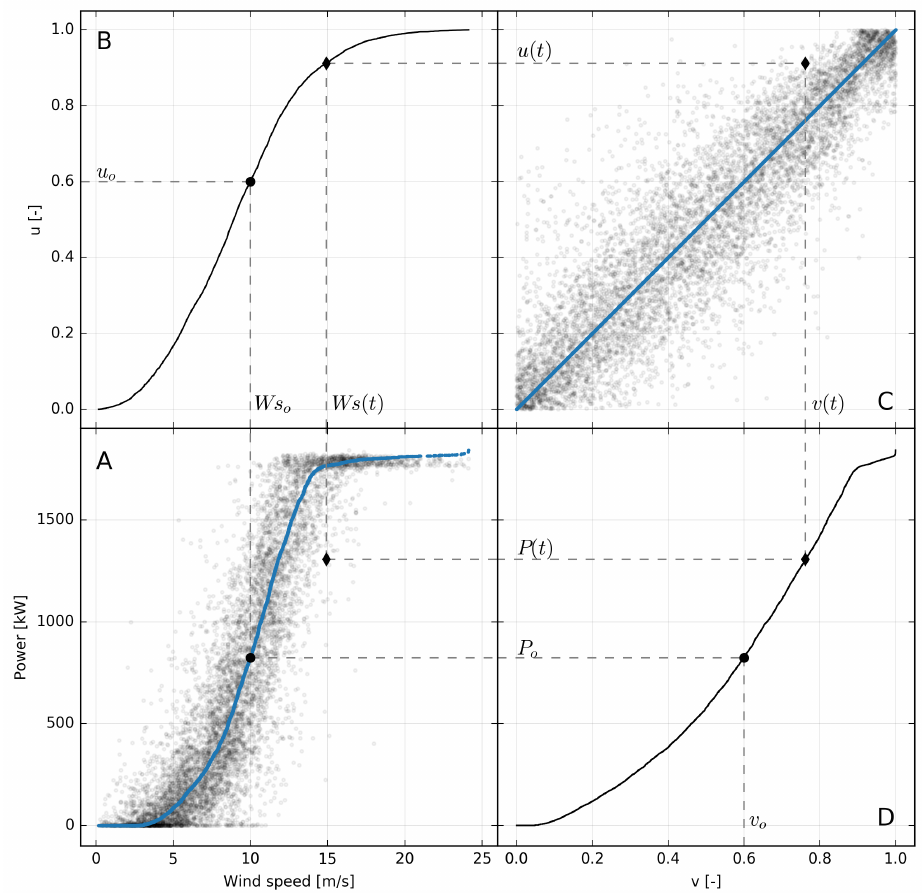
Figure 4. Illustration of the dm method. Box A shows measured power production against 100 m wind speed forecast for turbine 1. B and D boxes show the quantiles u , v of the cumulative distributions of wind speed and power. In box A the blue line associates the value of the wind speed for each quantile to the value of the power in the homologous quantile. This curve relates wind speed with the power, by mapping their distributions and constitutes the proposed model. Finally box C shows wind speed forecast and corresponding measured power in the [ u , v ] copula space. The dm is here the line that bisect the [ u , v ]